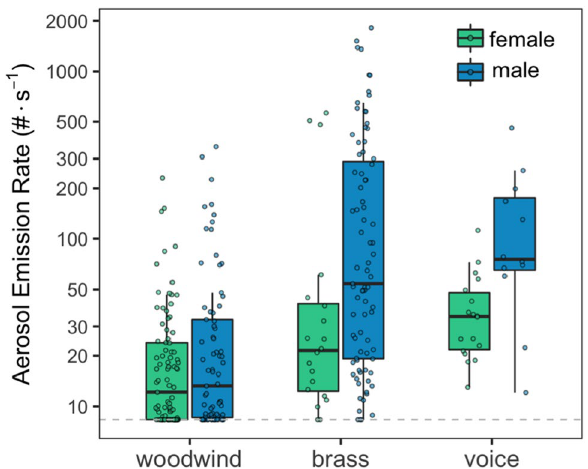
Figure 2. Boxplots of aerosol number emission rates (0.25–35.15 μm size range) by instrument class and participant sex (assigned at birth). Box limits delineate the inter-quartile range (IQR) with median values at center; whiskers extend to 1.5 ⋅ IQR or the data minimum. The dashed horizontal line represents a method quantification limit (8.3 particles per second). All data are background